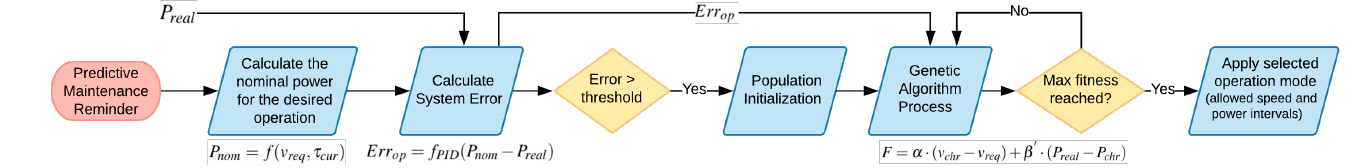
Figure 5. The general process of the adaptive scheduling